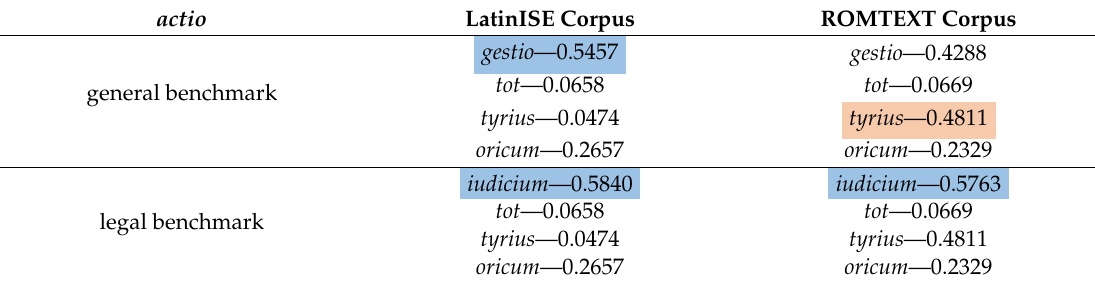
Table 2. Word embeddings accuracy calculated with pairwise fastText similarity scores on the example of the target word actio —Blue highlights the correct answers, orange the incorrect